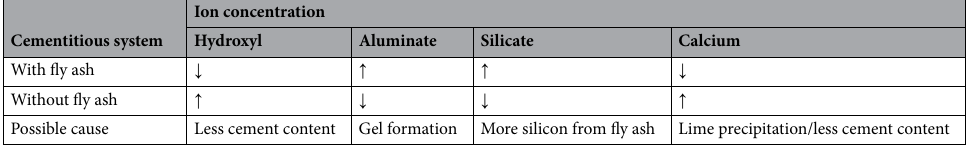
Table 3. Summary of ion concentration of cementitious containing fly ash.